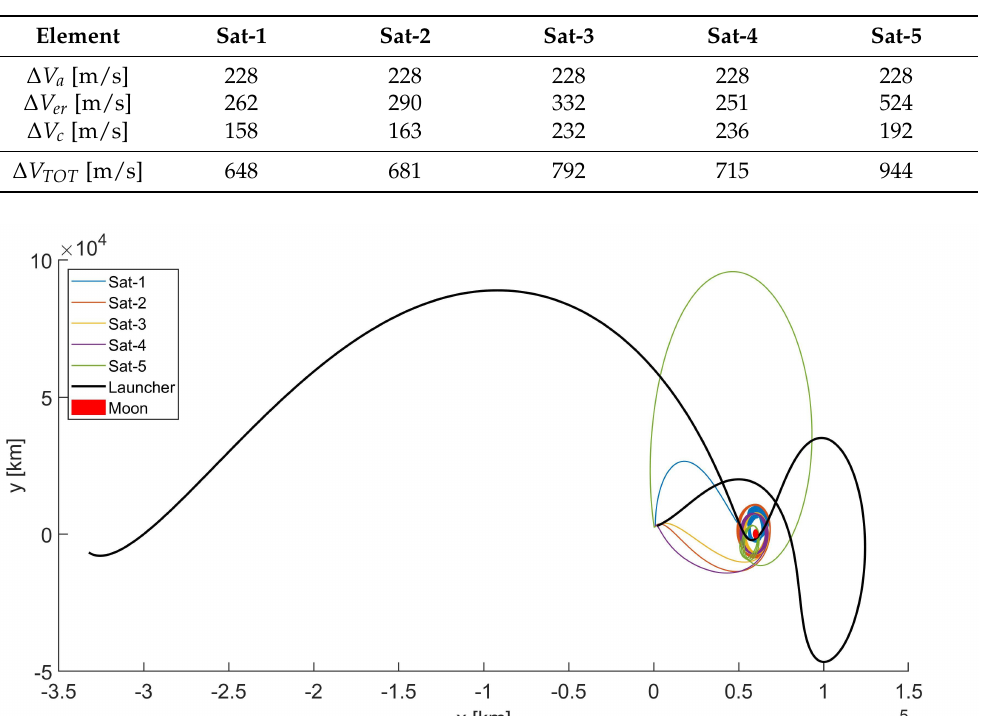
Table 6. Required ∆ V by each satellite on the different mission phases.